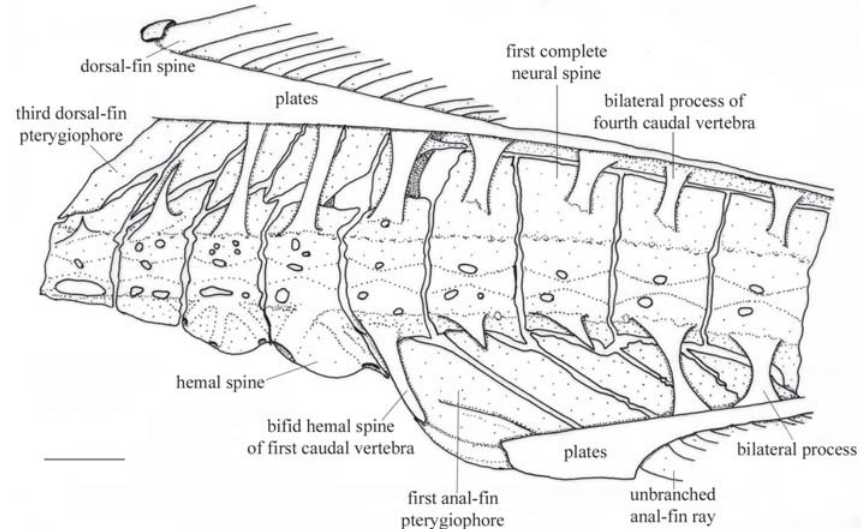
Fig. 40. Lateral view of the portion of the axial skeleton associated with the dorsal and anal-fin pterygiophores (right side) of Lamontichthys filamentosus (LACM 41741-9, 119.4 mm SL). Scale bar = 3